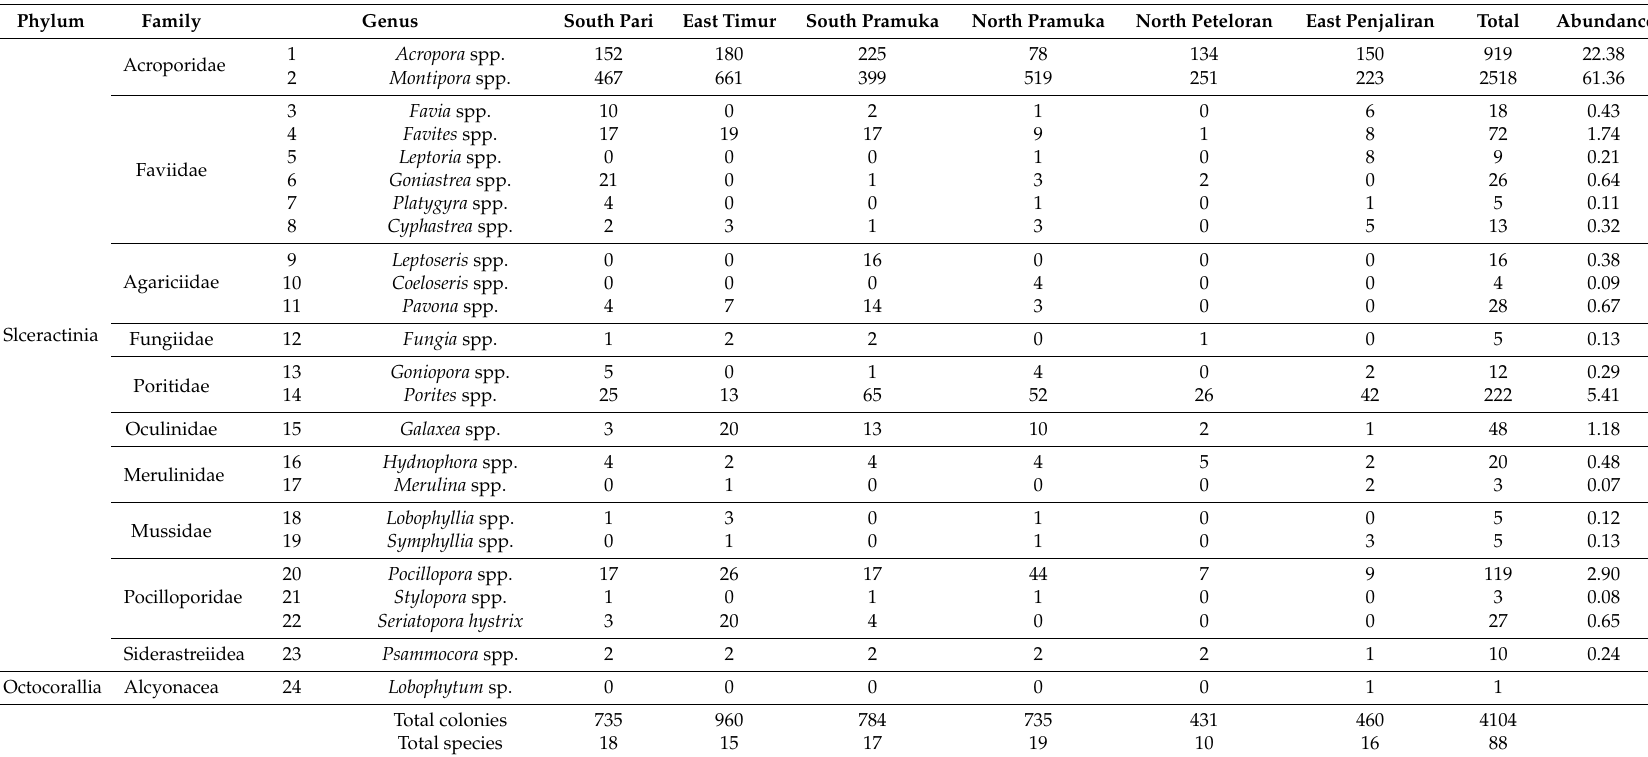
Table 2. Coral genera and number of colonies found across sites in shallow water less than 2 m depth. Coral Montipora spp. are more abundant than other genera.